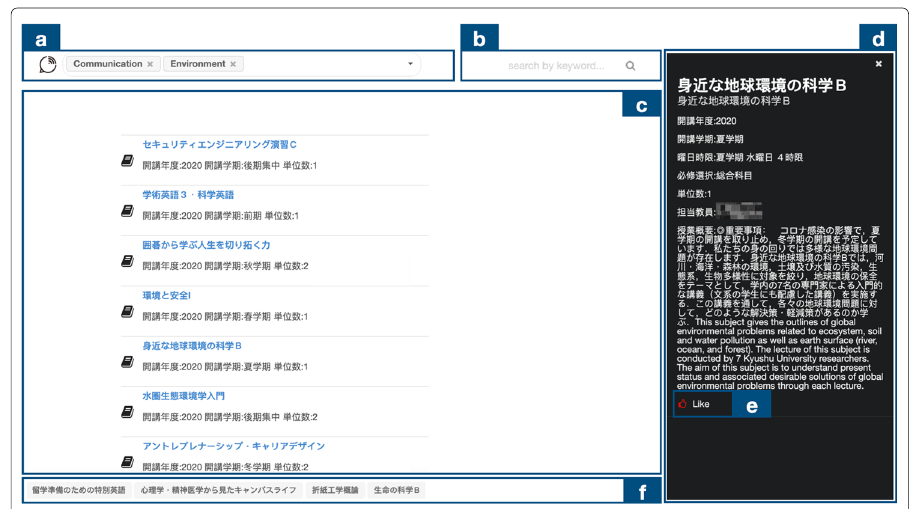
Fig. 6 The screenshot of the baseline interface. The interface shows recommended courses in left and details in right. (a) Keyword input area, (b) Search bar, (c) Recommendation list, (d) Information sidebar, (e) “Like” button, (f) “Like” list. (Some text is in Japanese, and the instructor name has been pixelated for privacy